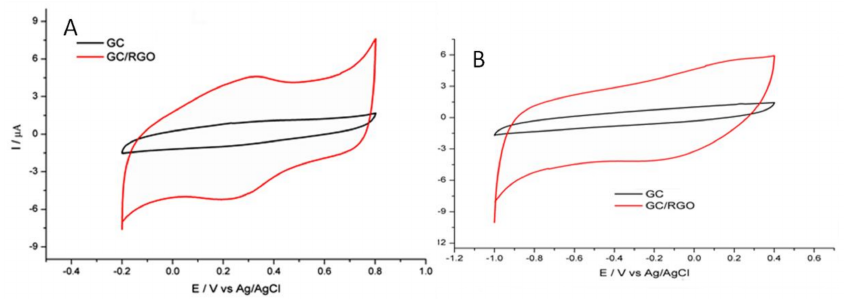
Figure 2. Cyclic voltammograms recorded for pristine GC and GC/reduce graphene oxide (RGO) in 0.1 M HClO 4 ( A ) and 0.05 M ethylenediaminetetraacetic acid (EDTA) ( B ). Scan rate at 50 mV/s.